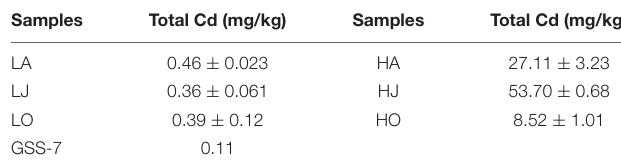
TABLE 1 | Total cadmium content of